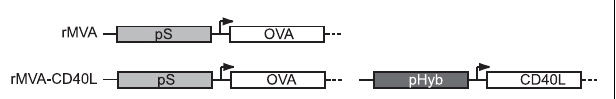
FIGURE 2 | Schematic representation of rMVA and rMVA-CD40L . Recombinant MVA encoding OVA alone or OVA together with murine CD40L were generated as described in Materials and Methods. OVA expression is controlled by the early/late synthetic promoter (pS) and CD40L expression by the recently described early/late hybrid promoter (pHyb)